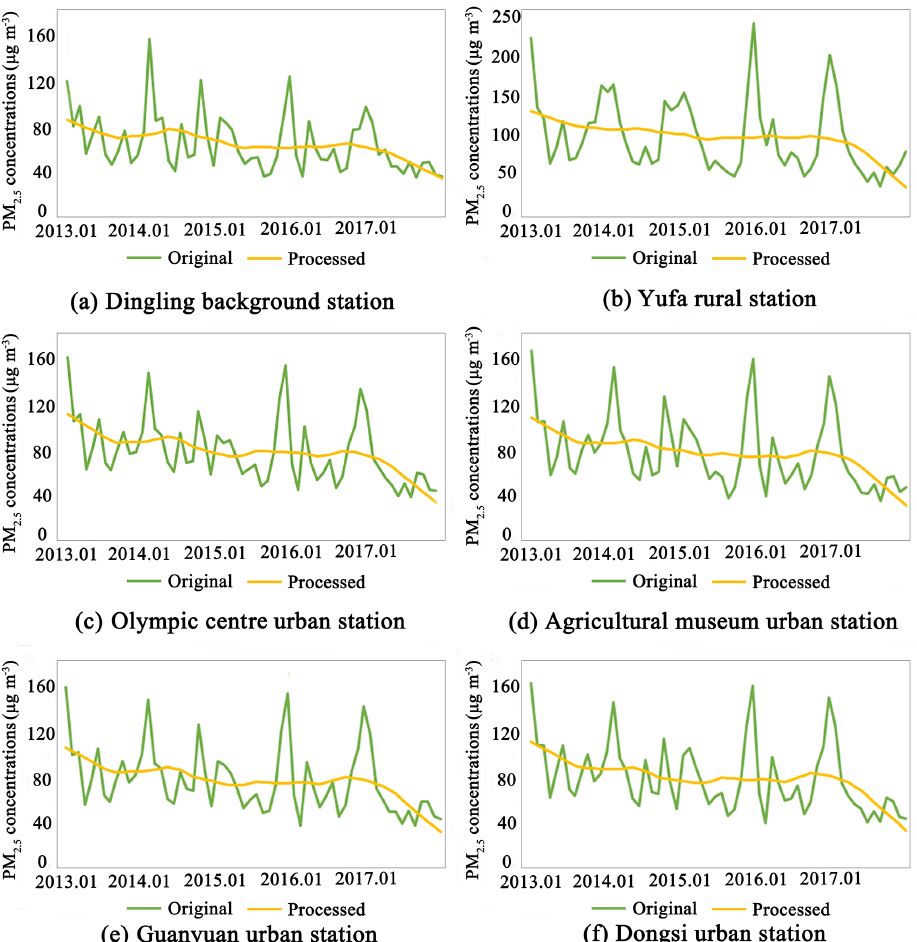
Figure 4. The comparison of original and KZ processed time series of PM 2 . 5 concentrations at six stations from 2013 to